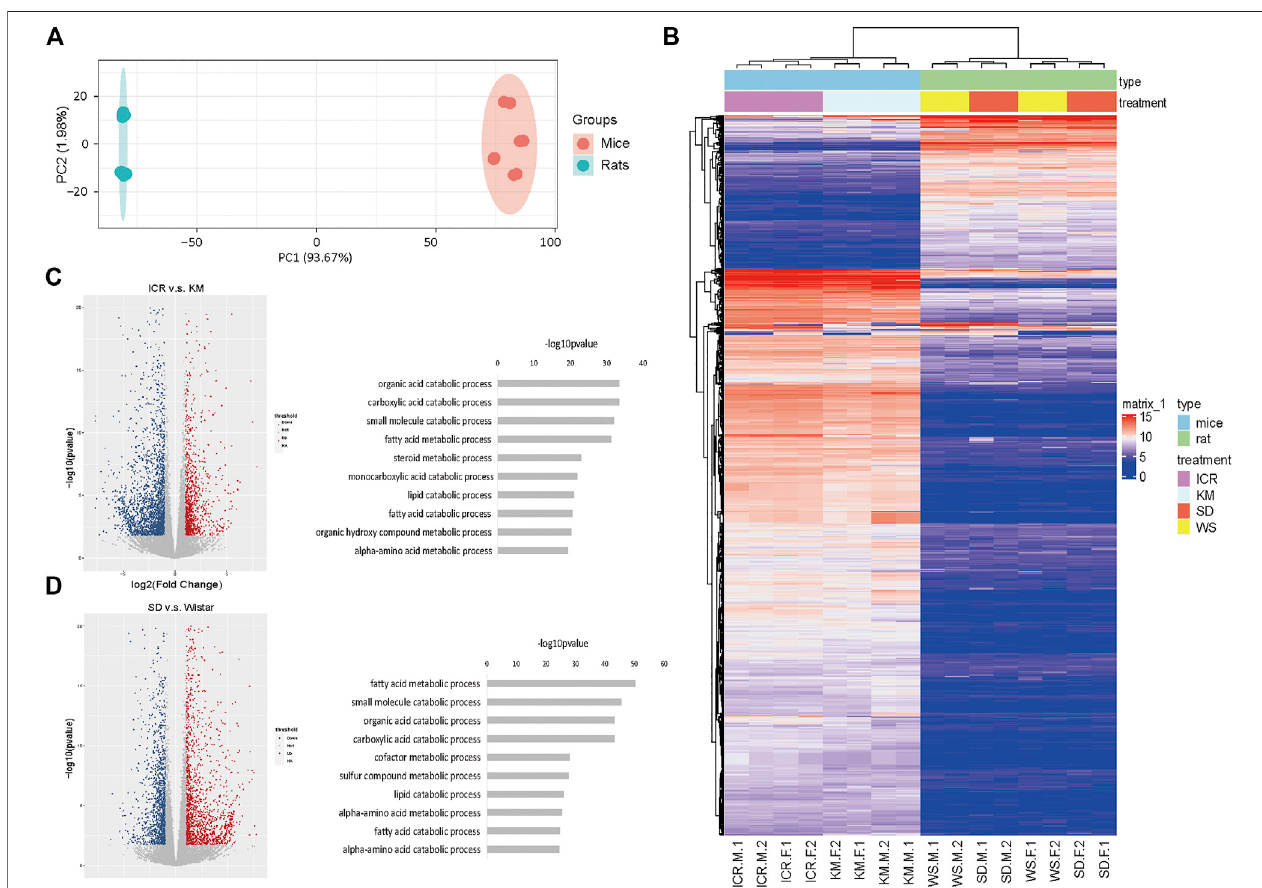
FIGURE2| Miceandhumanliverfunctiongenesweremoresimilarinexpression (A) PCApro fi leoftheexpressionofhomologousgenesinmice,rats,andhumans. (B) Volcanic map showing the upregulated genes in differentially expressed genes of mice compared to rats; (C) The top enriched GO terms of RNA-seq from the differentially expressed genes; (D) GSEA of homologous genes of mice and rats; (E) The top 200 genes enriched GO pathway terms of RNA-seq from the homologous genes of human, rats, and mice; (F) RNA-Seq data of three cases of human liver from young adults downloaded and analyzed using the available literature; the homologousgenesofhumans,rats,andmicewereselectedtoobtaintheexpressionmatrix,andthecorrelationmapofthegenesinthe fi rst3,000expressionlevels; (G) Dot plot of correlation value in humans, rats, and mice.